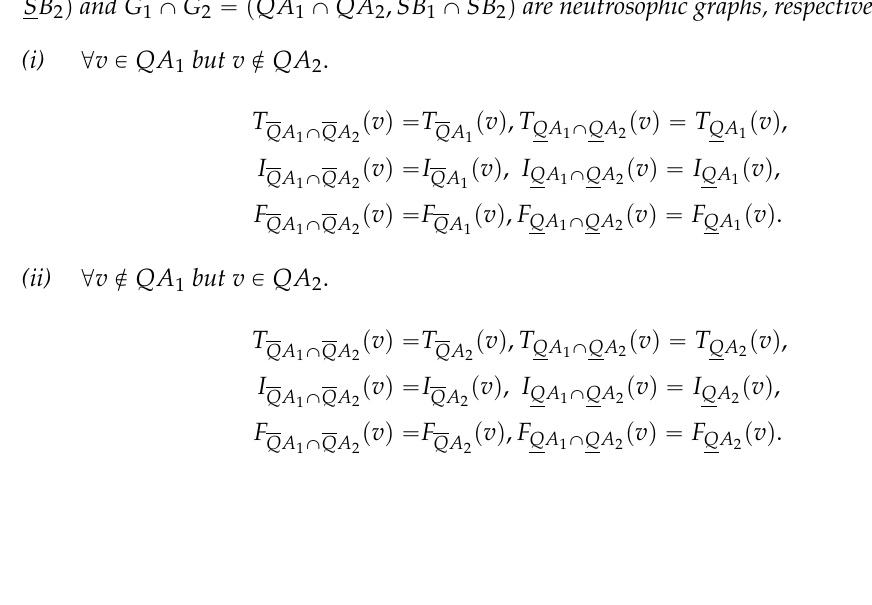
G 2 ) G , G 1 1 ∪ 2 G 2 ) Figure 4. Neutrosophic soft rough graph G 1 Y G 2 “ p G 1 Y G 2 , G 1 Y G 2 G , G 1 ∪ 1 ∪ 2 ∪